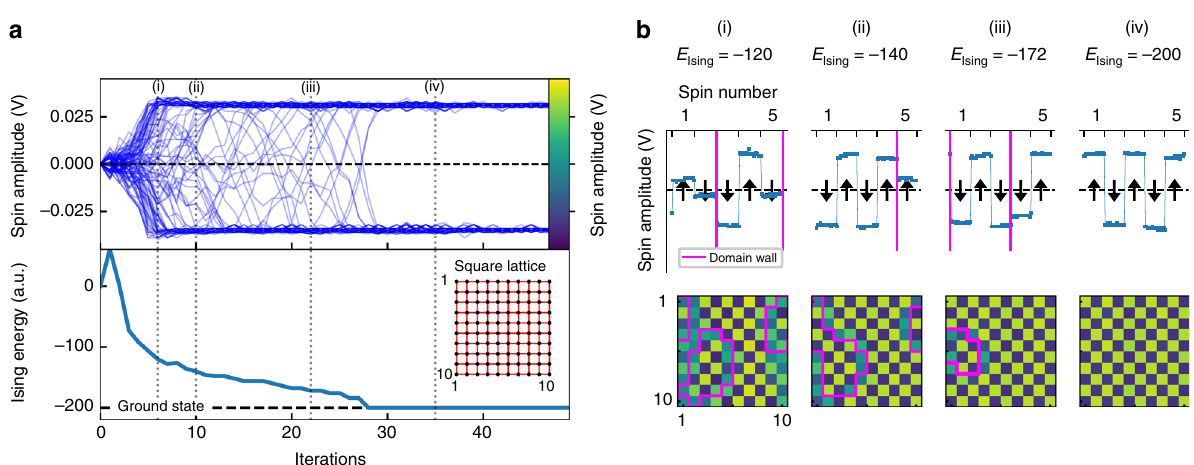
Fig. 3 Spin dynamics during a ground state search in a square lattice. a Time evolution of spin amplitude and Ising energy during the ground state search in a 10 by 10 square lattice for α = 0.25, β = 0.29. (inset) Graph structure of the square lattice. Black dots indicate the position of spins and red links indicate antiferromagnetic coupling. Links for periodic boundary conditions are not visualized. b Snapshots of the arti fi cial spins during the ground state evolution. The spin amplitude is color coded, so that yellow indicates spin up and blue indicates spin down. The respective color bar is shown in a . Domain walls are indicated by magenta lines. Also shown is the sampled photovoltage signal and the respective spin state for the fi rst 5 spins in row 5